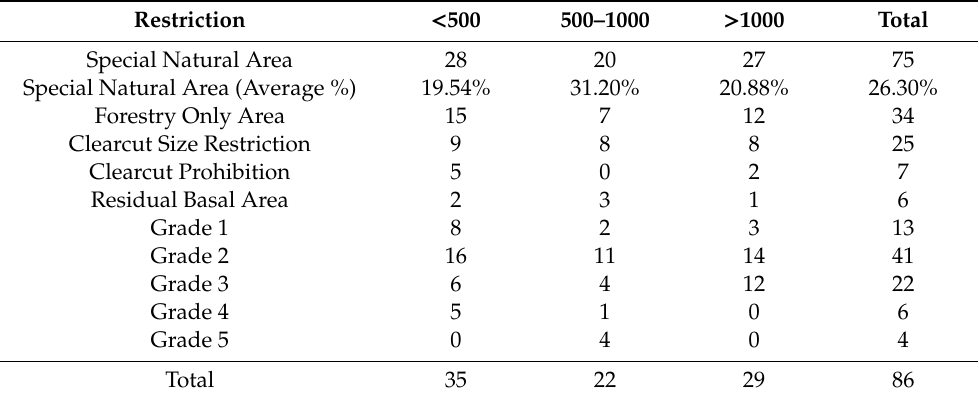
Table 5. Management restrictions and their relative frequency based on 86 WFCEs in Georgia. Restriction < 500 500–1000 > 1000 Total Special Natural Area 28 20 27 75 Special Natural Area (Average %) 19.54% 31.20% 20.88% 26.30% Forestry Only Area 15 7 12 34 Clearcut Size Restriction 9 8 Clearcut Prohibition Residual Basal